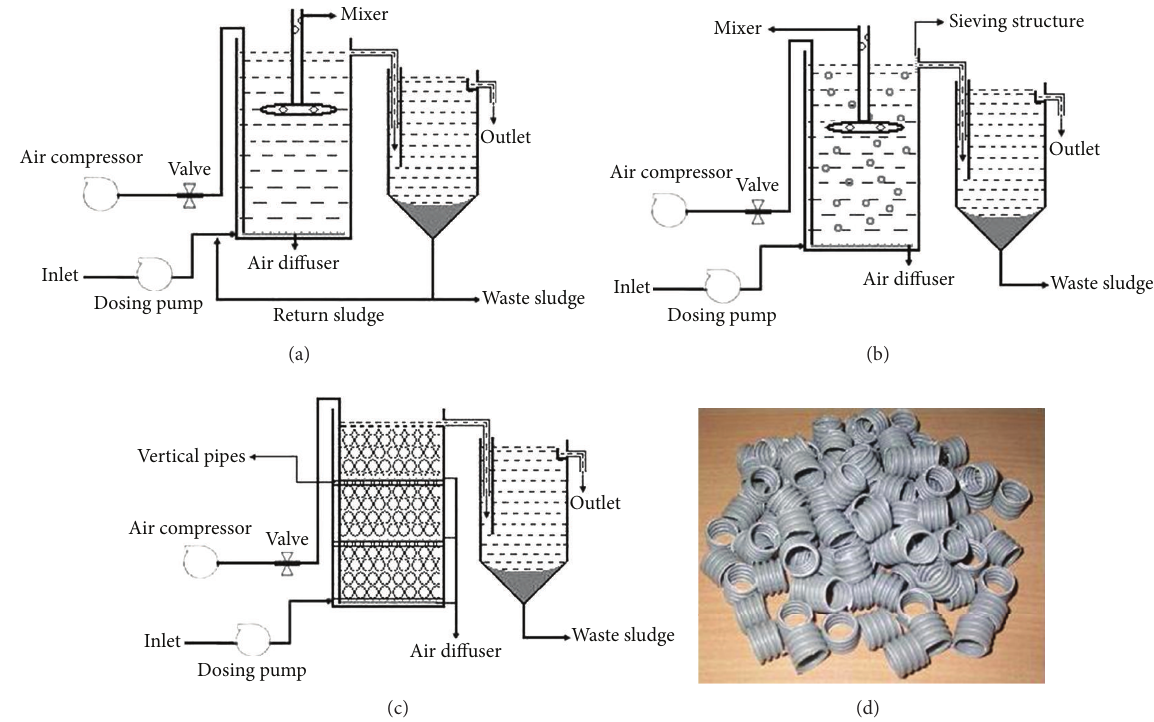
Figure 1: The schematic appearance of biological treatment processes ((a) ASP, (b) MBBR, (c) PBBR, (d) carrier media).